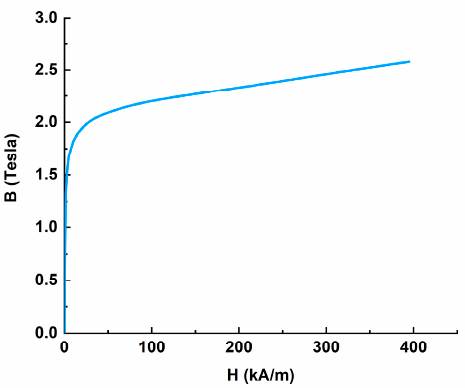
Figure 1. The B–H curve of 1008 steel.